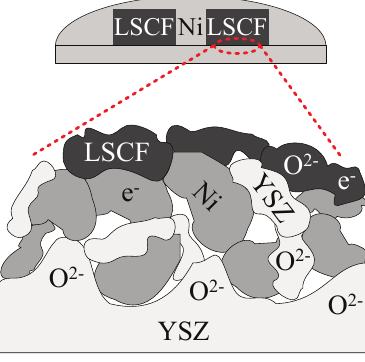
Figure 8. Schematic of the LSCF-Ni/YSZ anode cross-section with LSCF mixed conductor, Ni electronic conductor and YSZ ionic conductor